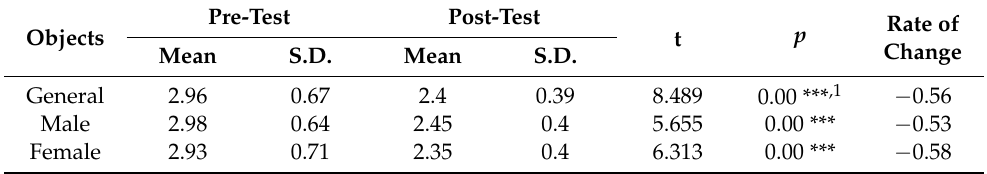
Table 1. Changes in the SIAI-S scores before and after viewing the urban landscape forest pictures.